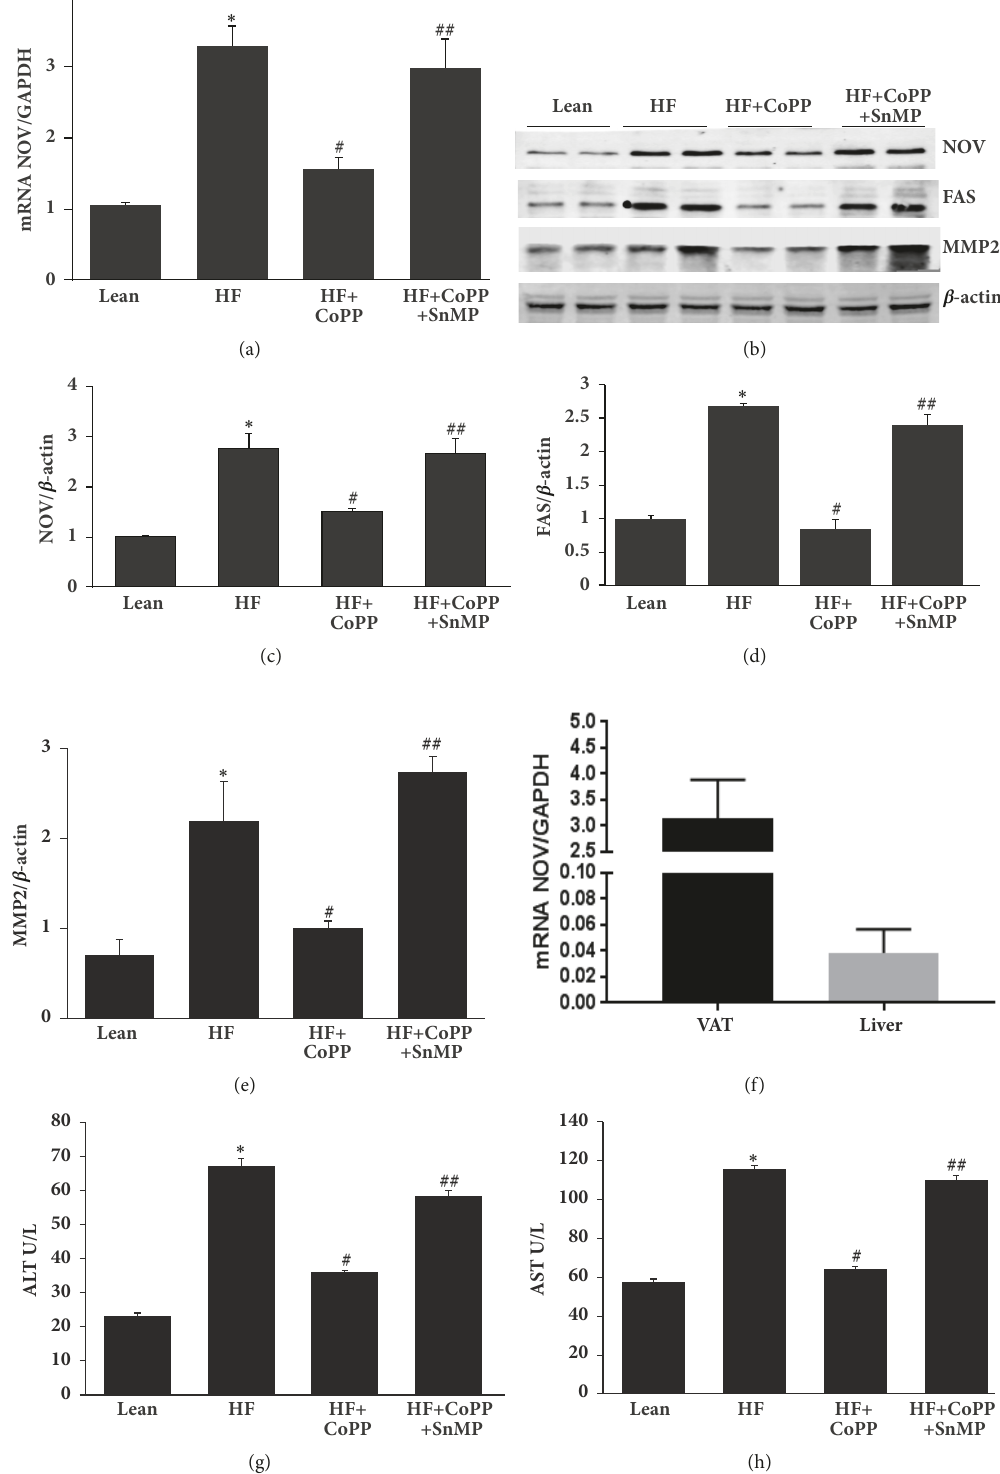
Figure 2: Induction of HO-1 decreases NOV and fibrotic markers and improves ALT and AST. (a) The mRNA expression of NOV, (b) representative western blots and densitometry analysis of (c) NOV, (d) FAS, and (e) MMP2 and levels of (f) AST(U/L), and (g) ALT(U/L) in hepatic tissues of control lean mice, HF fed mice, HF fed + with CoPP, and HF fed mice + CoPP + SnMP. (h) NOV mRNA levels in visceral adipose tissue (VAT) and liver of lean mice. Results are mean ± SE, n=6, ∗ p < 0.05 versus lean mice, #p < 0.05 versus HF fed mice, and ##p < 0.05 versus HF fed mice +